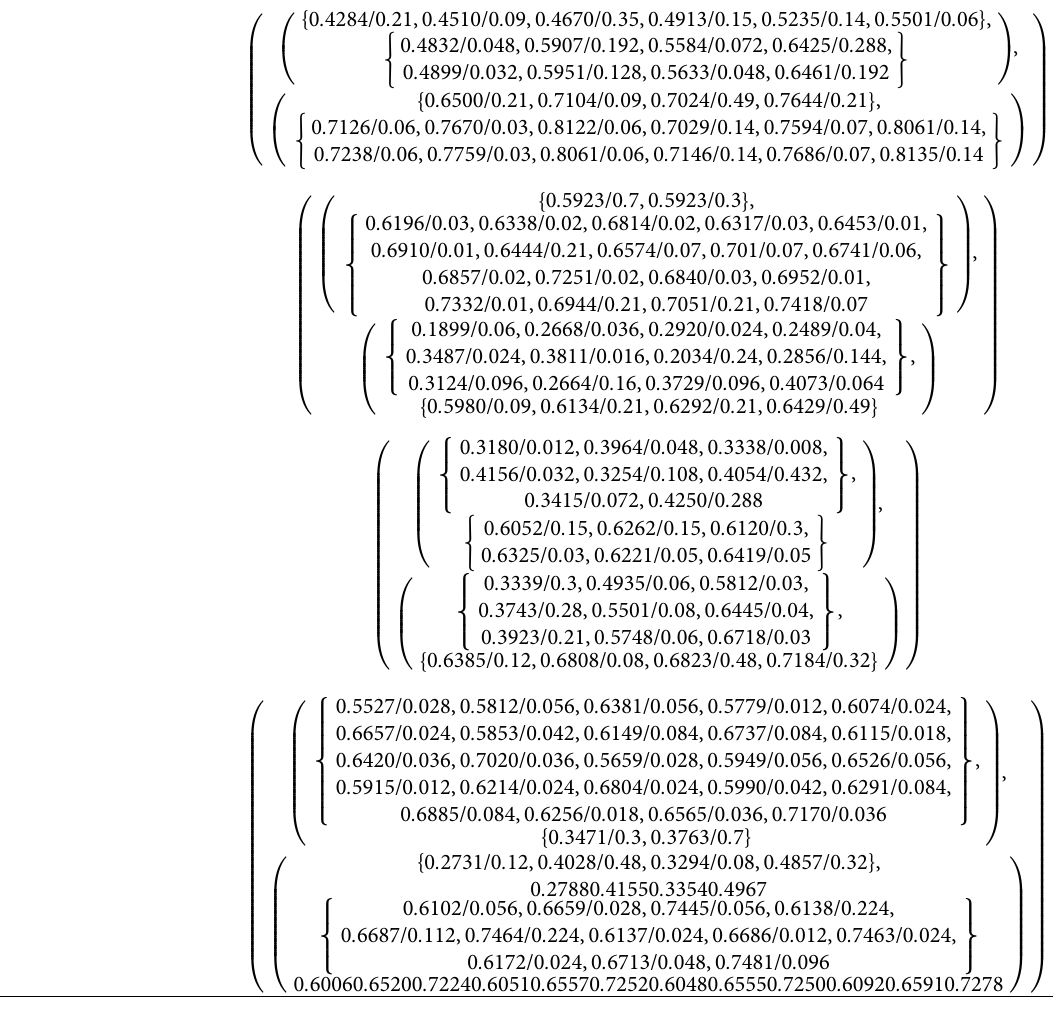
Table 12: Updated aggregated information using q -ROPHFREWG.